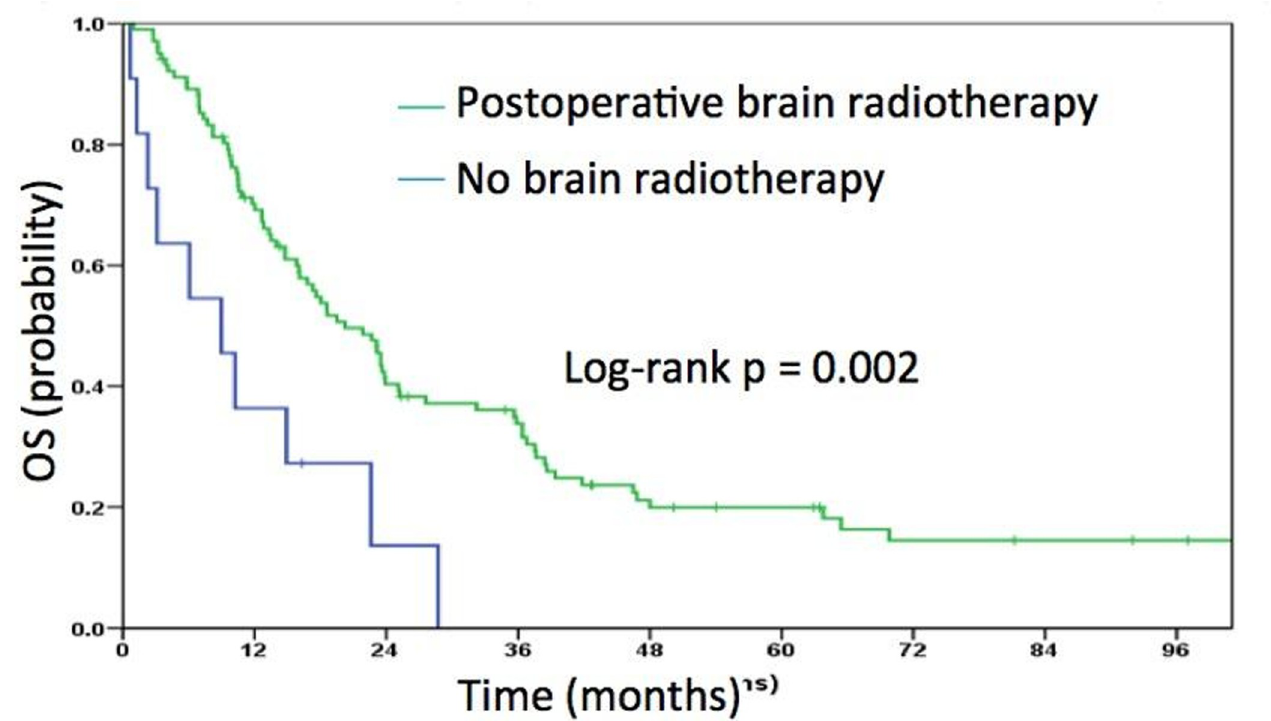
Fig 4. Overall survival for patients treated with or without postoperative radiotherapy.